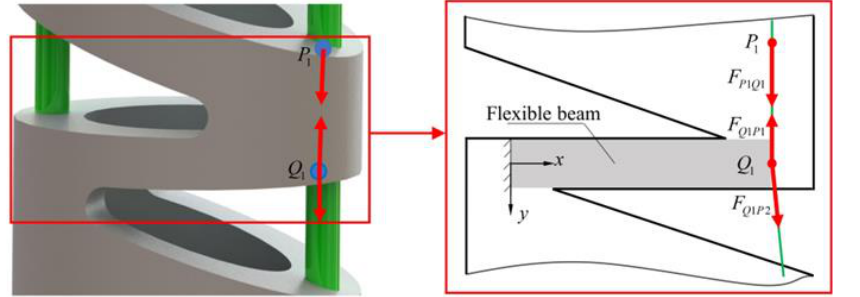
Figure 2. Force on end notch of the NCR.